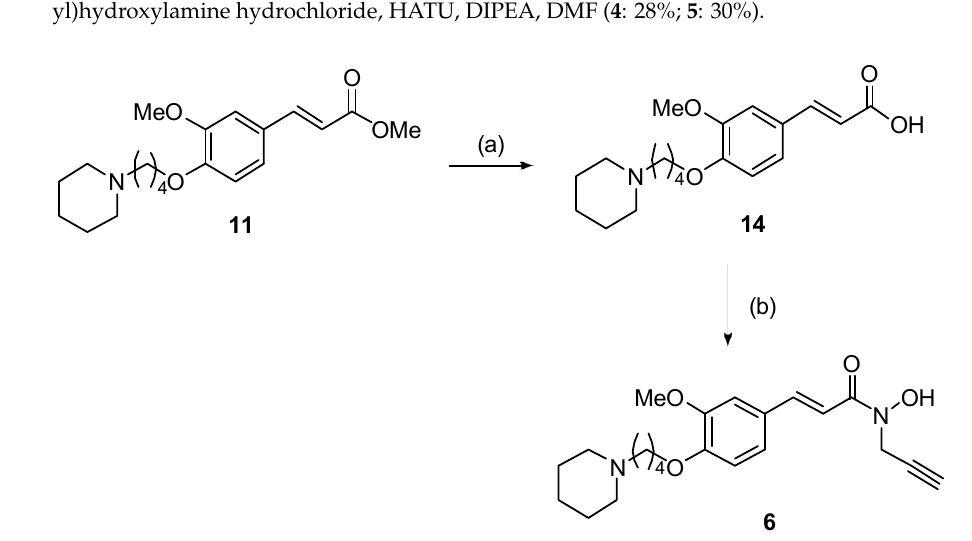
Scheme 4. Reagents and conditions: ( a ) K 2 CO 3 , MeOH/H 2 O (48%); ( b ) N ‐ (prop ‐ 2 ‐ yn ‐ 1 ‐ yl)hydroxyl ‐ amine hydrochloride, HATU, DIPEA, DMF